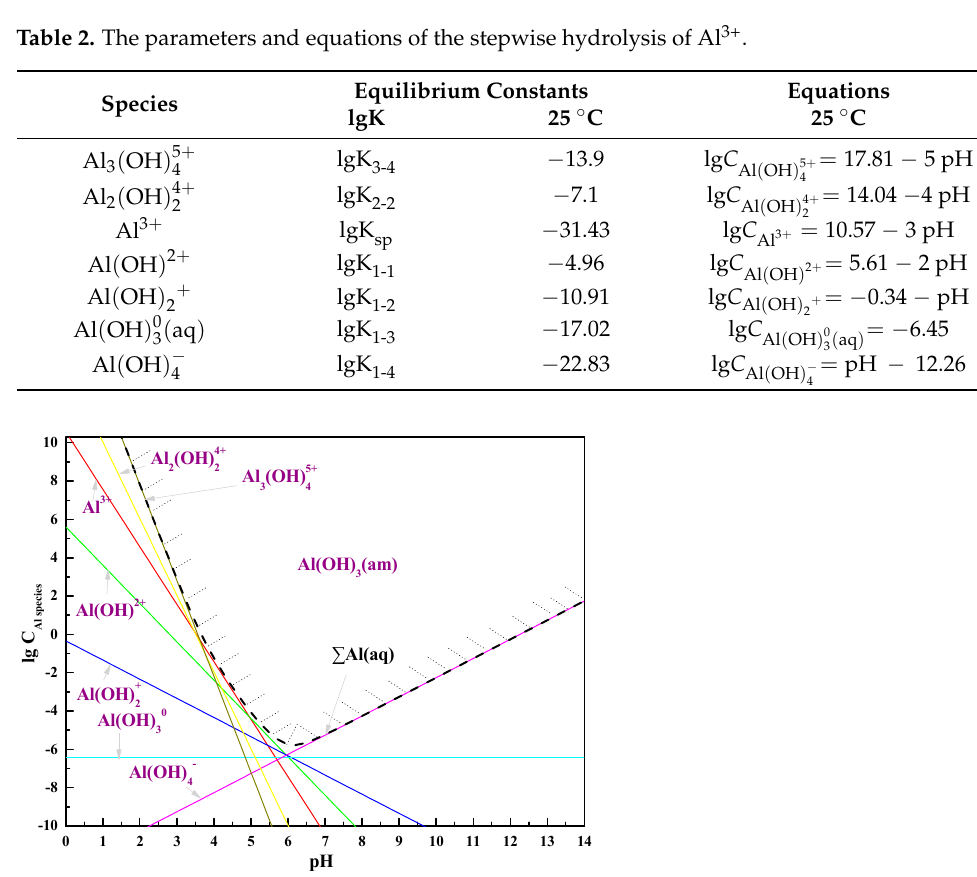
Figure 4. Theoretical aluminum solubility diagram in equilibrium with amorphous aluminum hydroxide Al(OH) 3 (am), 25 °C.